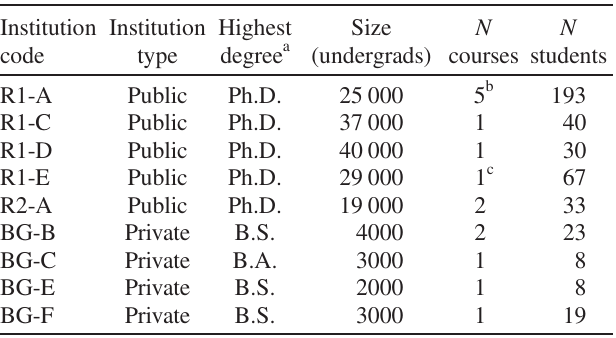
collected post-test CMR CUE data. N indicates the number of responses rather than the total number of students